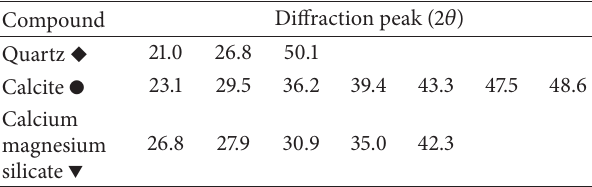
Table 2: Diffraction peaks of each compound.